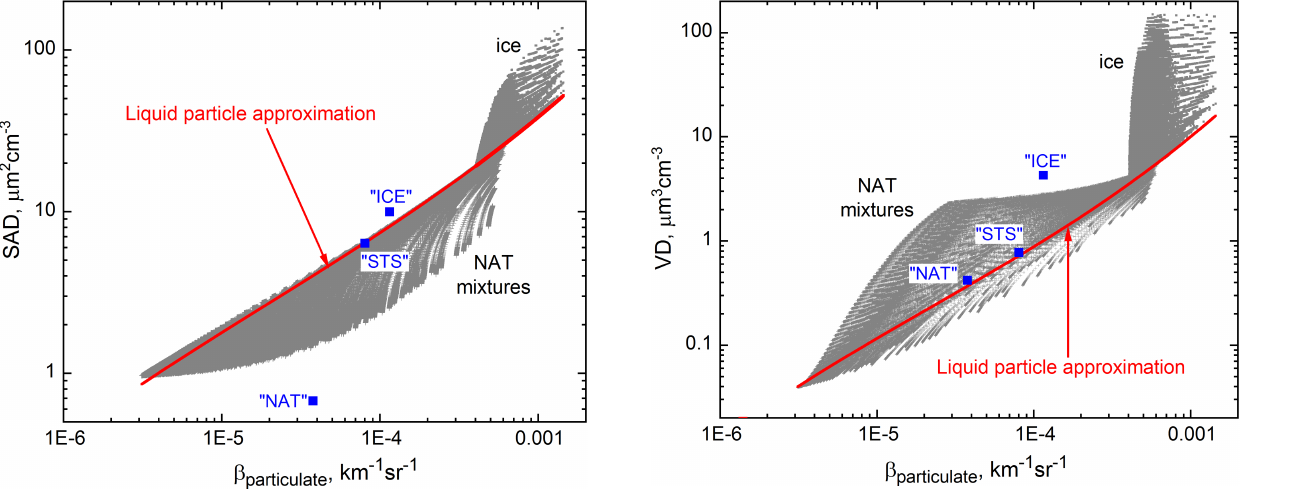
Figure 8. Theoretical particulate surface area density (SAD) vs. β particulate from the full suite of results for NAT mixtures and ice, compared with the liquid particle approximation. Blue symbols are computed values based on bimodal lognormal size distribution fits to in situ optical particle counter measurements within STS, NAT, and ice PSC layers (Deshler et al., 2003).